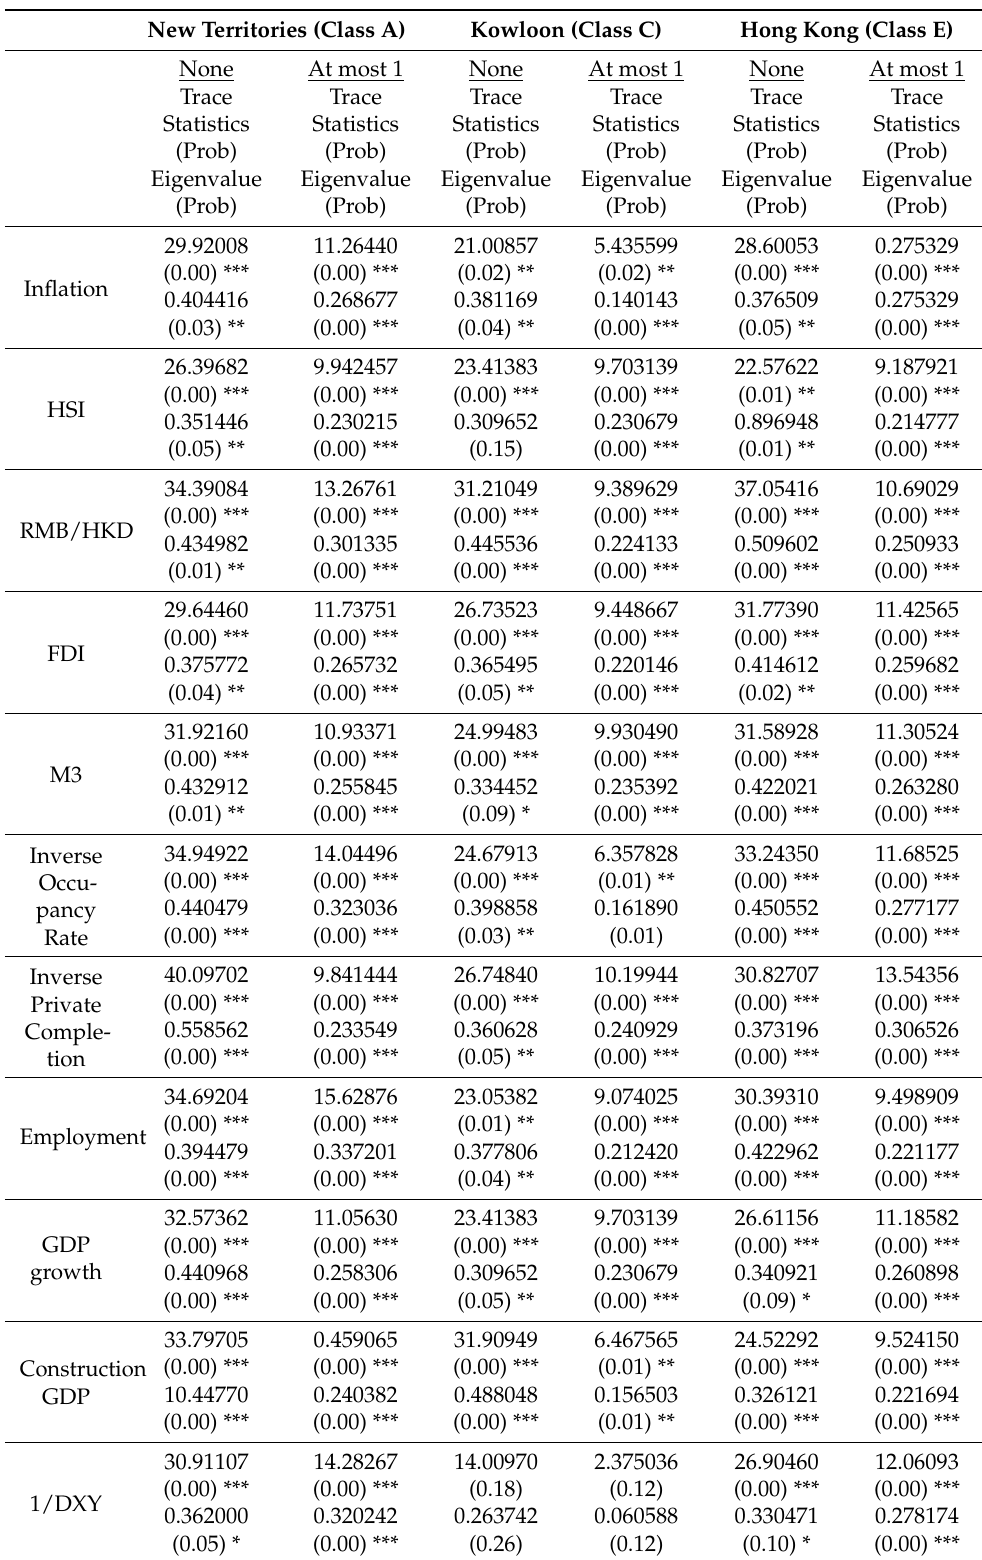
Table 3. Results of cointegration